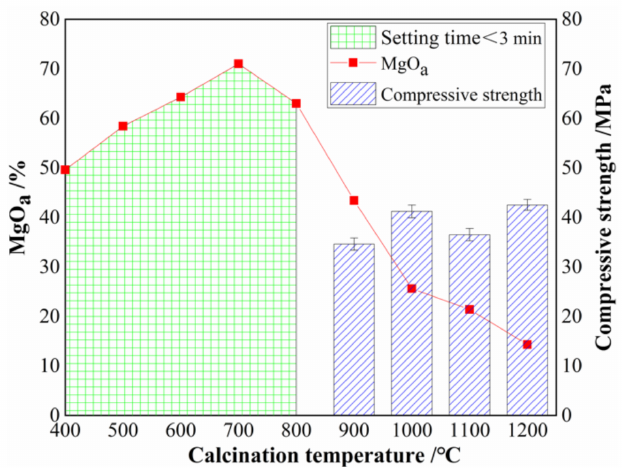
Figure 2. MgO a content and compressive strength (curing time = 1 day) changing curve with calcination